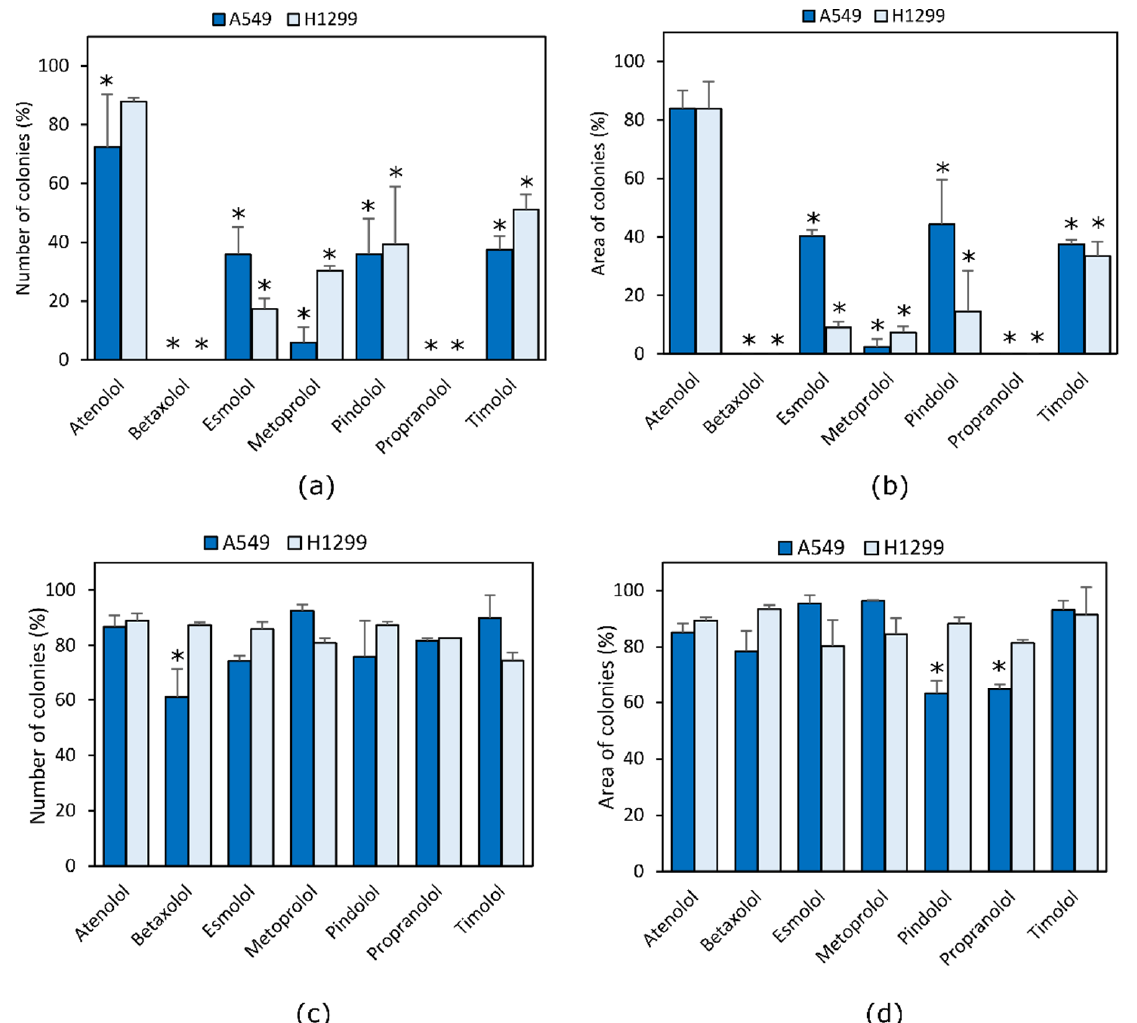
Figure 3. Effect of beta adrenoblockers on NCLSC cell colony formation ability. Comparison of com- pound effect of 90% of their EC 50 value on ( a ) cell colony number and ( b ) area of colonies; and com- pound effect of 10% of EC 50 value on ( c ) cell colony number and ( d ) area of colonies. * p < 0.05, compared to control.